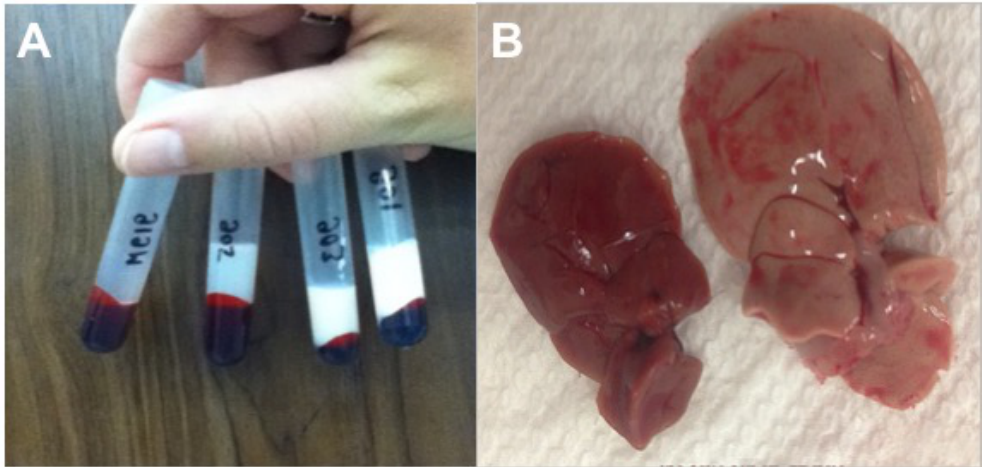
Figure 6. ( A ) Progressive stages of hyperlipemia in Nile rats with T2DM; ( B ) normal liver size and color ( left ) is contrasted by diet-induced hepatic enlargement and discoloration due to fatty liver (NAFLD) in advanced T2DM ( right ).